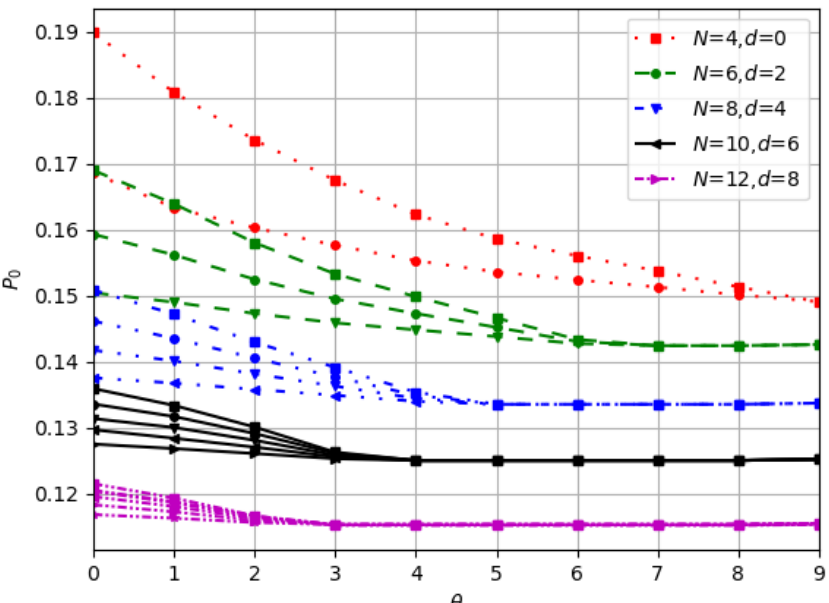
Figure 7. Probability of a system being idle for families of curves with two parameters: N (indicated by color), and d (indicated by marker).